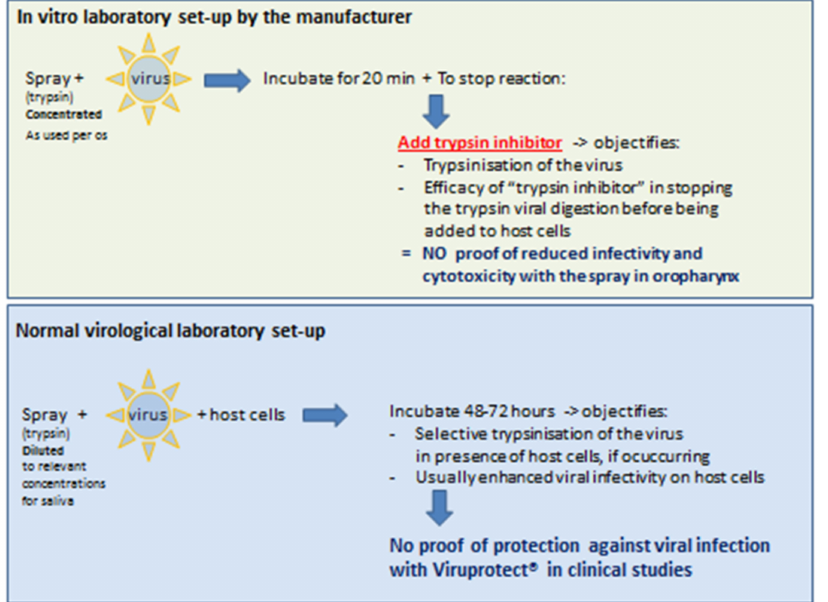
Figure 2. Differences in in vitro laboratory setup, as used by CZ-MD mouth spray, compared